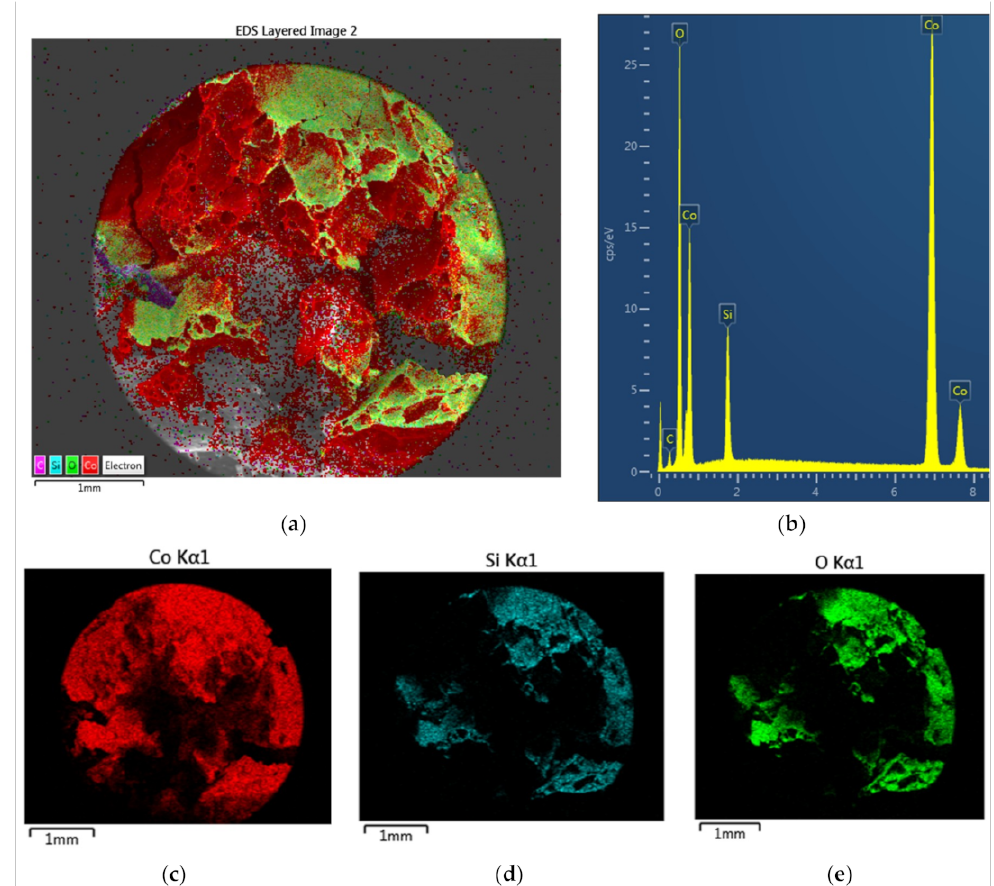
Figure 18. Elemental mapping and EDX-spectrum of a Co / Si = 1 / 1 catalyst particle. ( a ) EDS layered image; ( b ) EDX-spectrum of the catalyst particle which yields: [Co] = 0.413; [Si] = 0.067; [O] = 0.520; with [Co] / [Si] = 6.16 and [O] / ([Co] + [Si]) = 1.56; ( c ) Co-mapping; ( d ) Si-mapping; ( e ) O-mapping. Scale bar = 1 mm in all